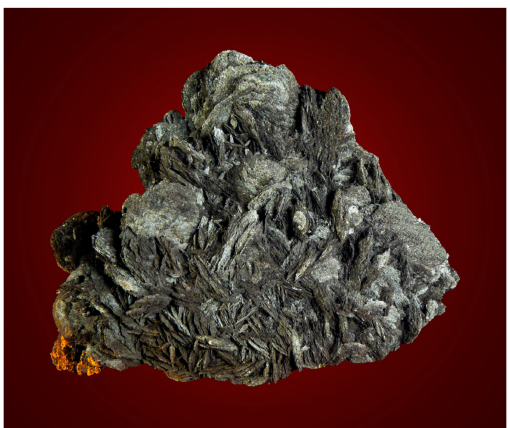
Figure 6. Hematite, Dodge mine. 11.2 cm. Chamberlain Collection, NYSM 41046. SC.